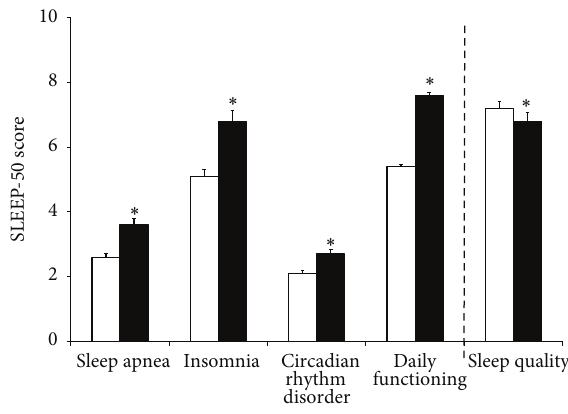
Figure 1: Mean (SE) scores of subjects with perceived normal health status (white bars) or perceived reduced immune functioning (black bars) on sleep disorders, sleep quality, and daily functioning. Significant differences ( 𝑝 < 0.05 ) are indicated by an